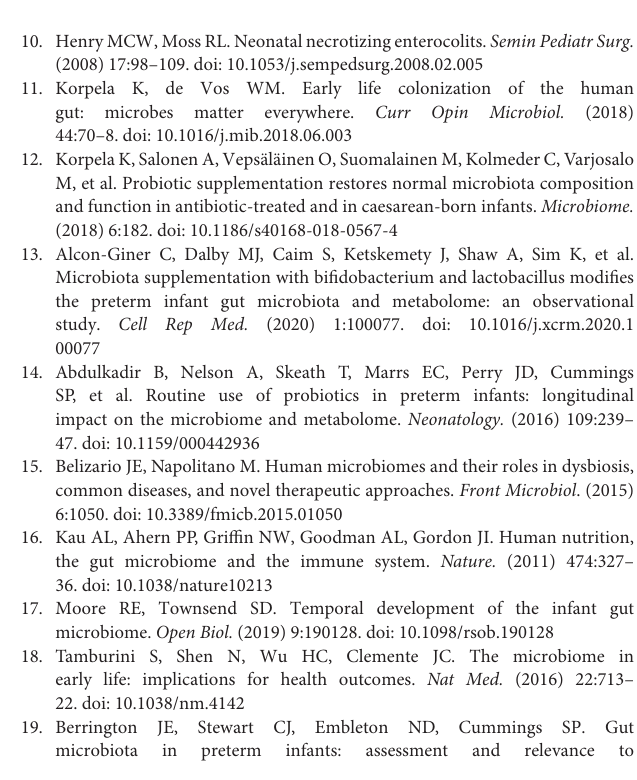
Supplementary File 1 | Supportive data not included in the manuscript. Supplementary File 2 | MetaCyc Group data within species and across samples. Supplementary File 3 | Enzyme Commission data within species and across